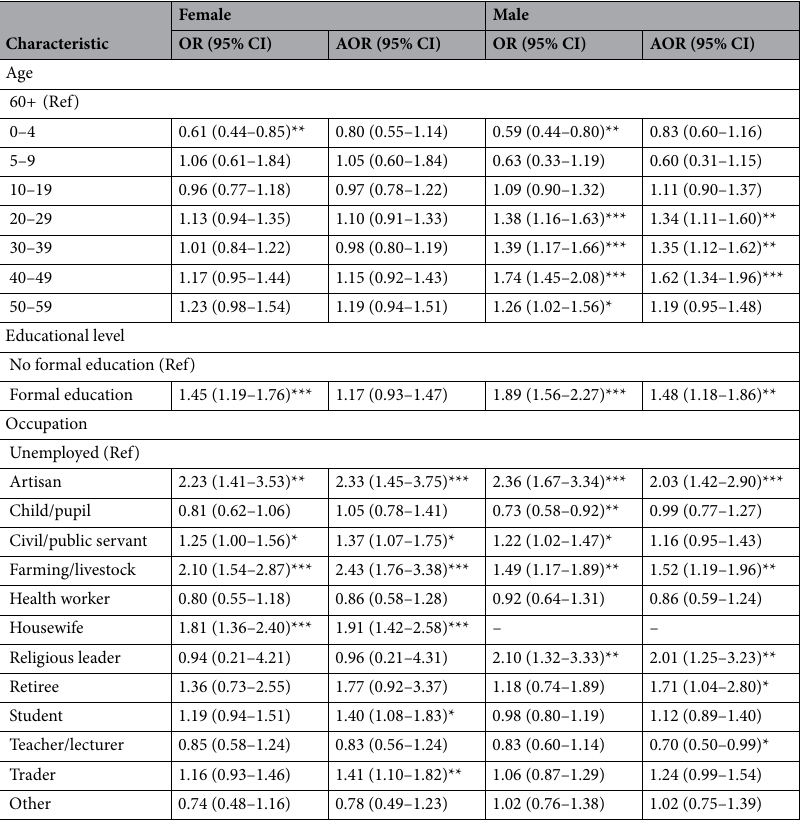
Table 3. Sex-disaggregated logistic regression models predicting Lassa fever case positivity. Season, year of report, and state of residence were controlled in the adjusted models. ***p < 0.001; **p < 0.01; *p <